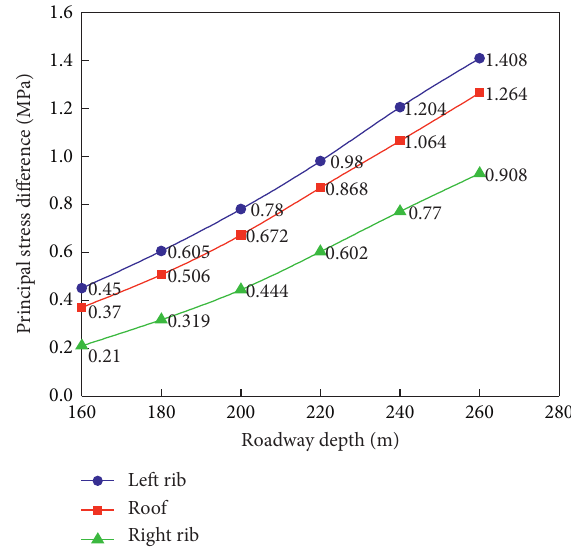
Figure 5: Principal stress difference under different roadway